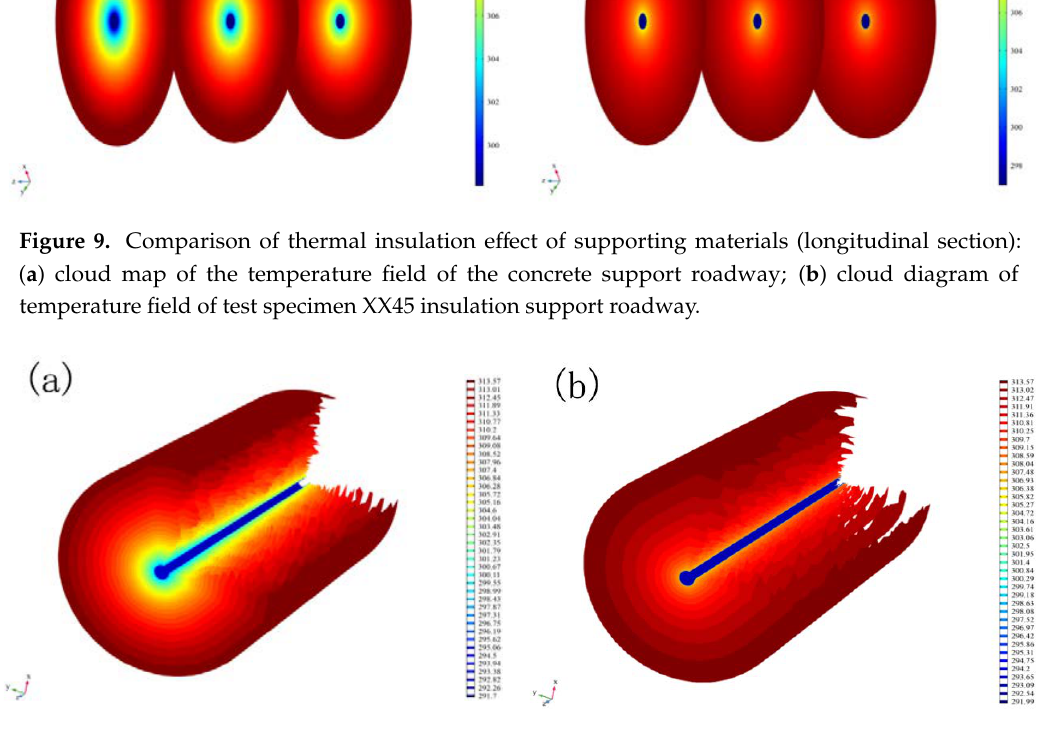
Figure 10. Temperature isosurface: ( a ) temperature isosurface of concrete support roadway; ( b ) temperature isosurface of roadway supported by test specimen XX45 insulation material.